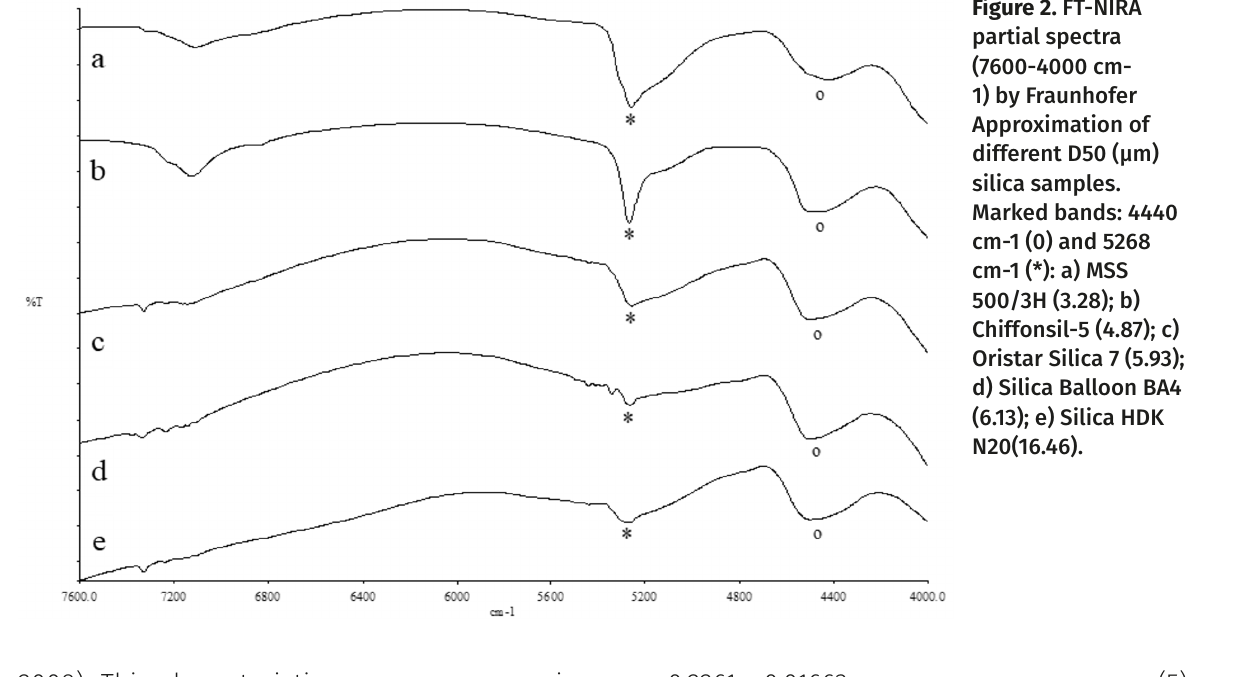
Figure 2. FT-NIRA partial